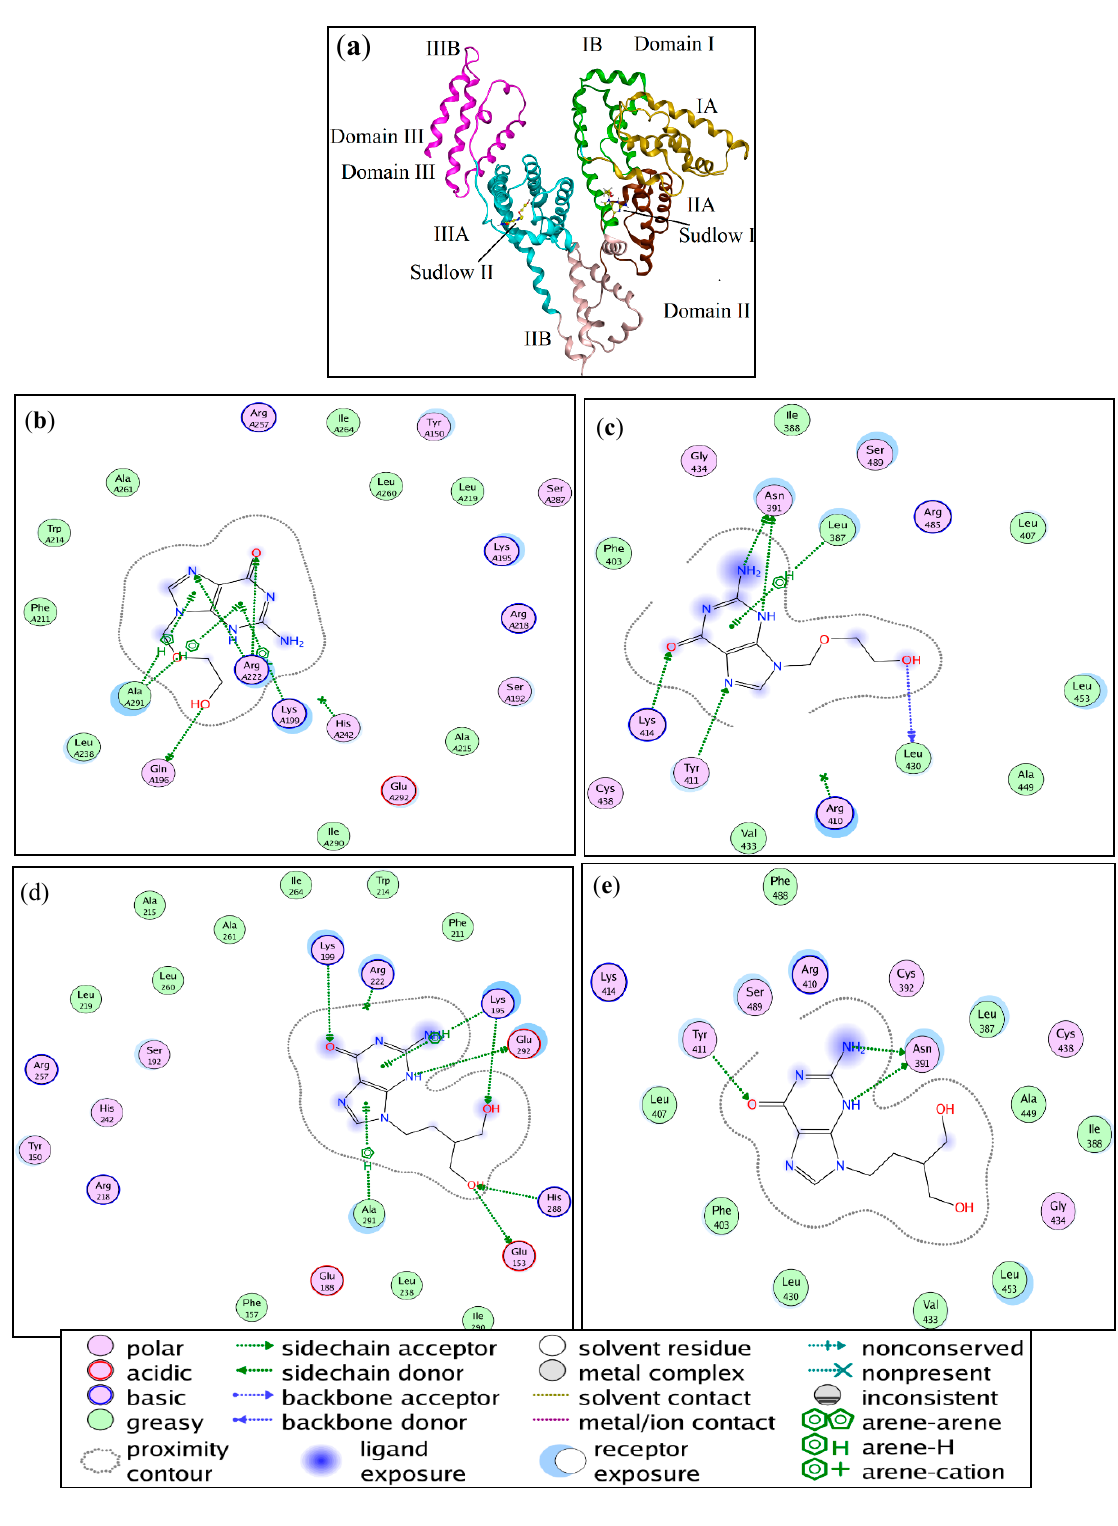
Figure 11. ( a ) A representation of the HSA subdomains and binding sites. Illustrations of the amino acid residues involved in the ACV-HSA interaction at ( b ) Sudlow site I and ( c ) Sudlow site II. Illustration of the amino acid residues involved in the PNV-HSA interaction at ( d ) Sudlow site I and ( e ) Sudlow site II.